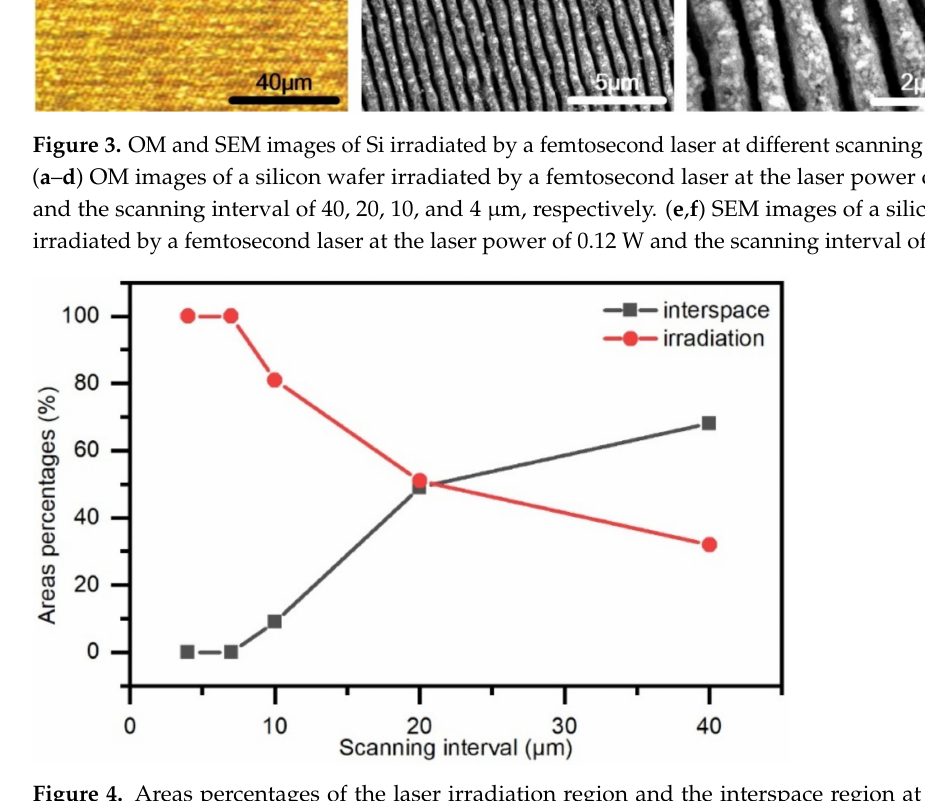
Figure 4. Areas percentages of the laser irradiation region and the interspace region at different scanning